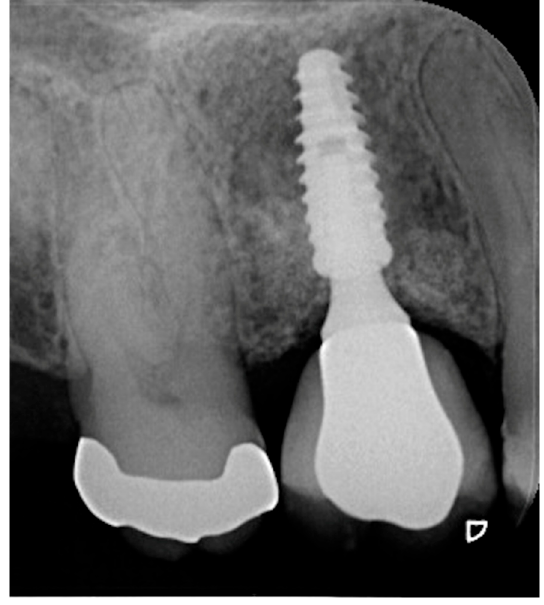
Figure 18. Periapical radiograph of #16 in function for 25 months.